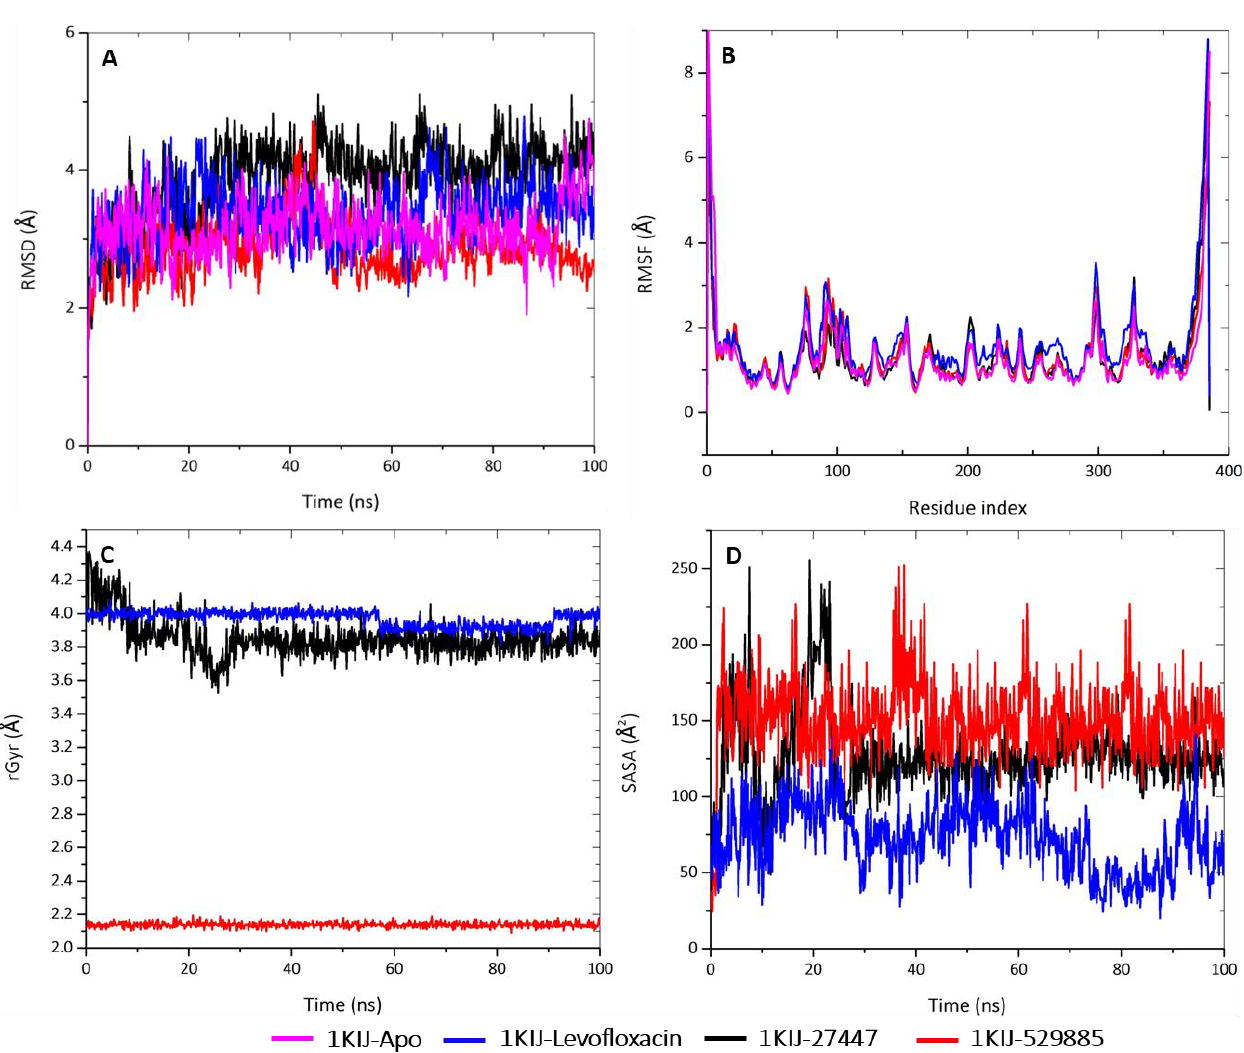
Figure 10. MD analyses of Apo-1KIJ and 1KIJ complexed to levofloxacin, cephalexin, and 1,3,3-trimethyl-2-oxabicyclo[2.2.2]octan-6-ol. ( A ) RMSD graphical illustration, ( B ) RMSF plot, ( C ) rGyr representation, and ( D ) SASA diagram. All MD simulations were performed by using Schrödinger version 2022_1.